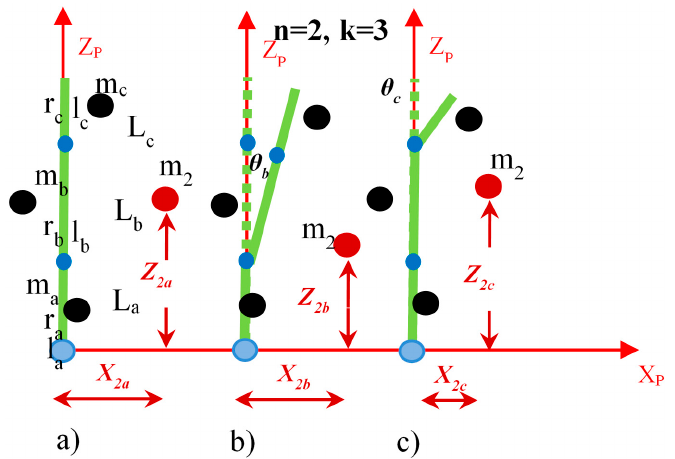
Figure 4. Sketch of a robot in a plane with 2 degrees of freedom. Three Configurations (a) – (c). m 2 is the total mass of the system; m a , … , m c are the masses of the links and r a , … , r c and l a , … , l c are respectively the x and z components of the center of mass of the links respect to the relative revolute joint; L a , … , L c are the lengths of the links.